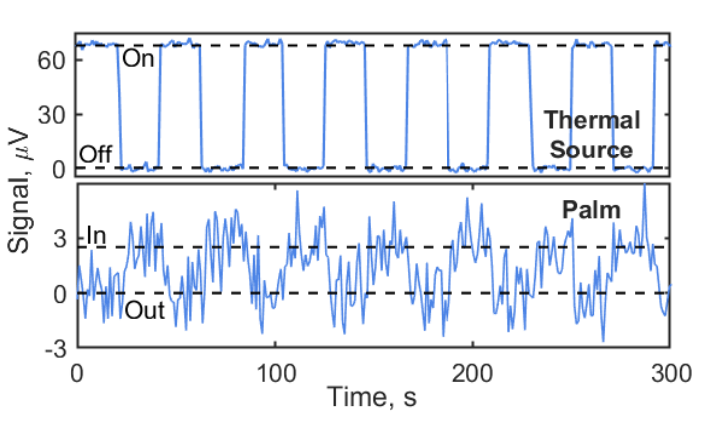
Figure 6. Detection of the radiation from the ceramic thermal source (top) and a human palm (bottom). In both cases, the radiation is mechanically chopped for lock-in detection. On/Off (In/Out) modulation at 25 mHz (period of 40 s). The signal-to-noise ratio (SNR) is 54 for the ceramic source, and 1.97 for the palm. The noise-equivalent temperature difference (NETD) for the latter amounts to 4.4